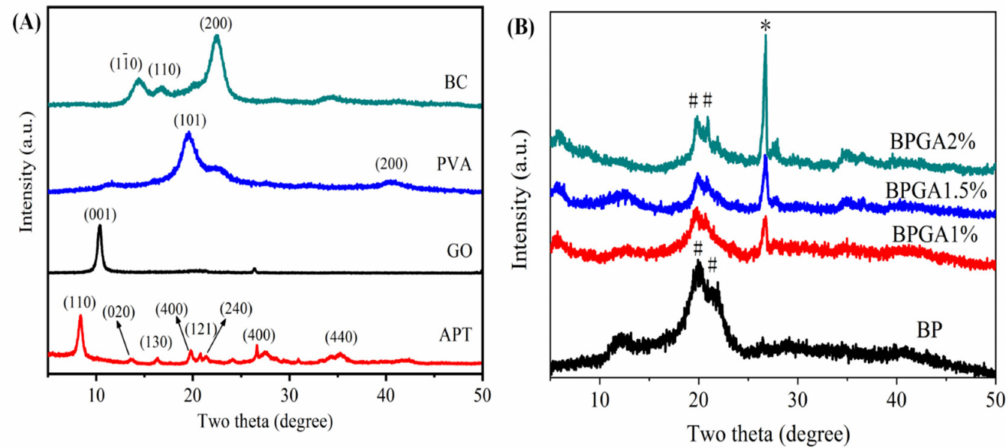
Figure 2. The X-ray di ff raction spectra of initial components and prepared adsorbent materials. Frame ( A ) indicates the X-ray di ff raction spectra of initial components (BC, PVA, APT and GO) and ( B ) indicates the X-ray di ff raction spectra of prepared adsorbent materials (BP, BPGA1%, BPGA1.5% and BPGA2%), (*) APT, (#)